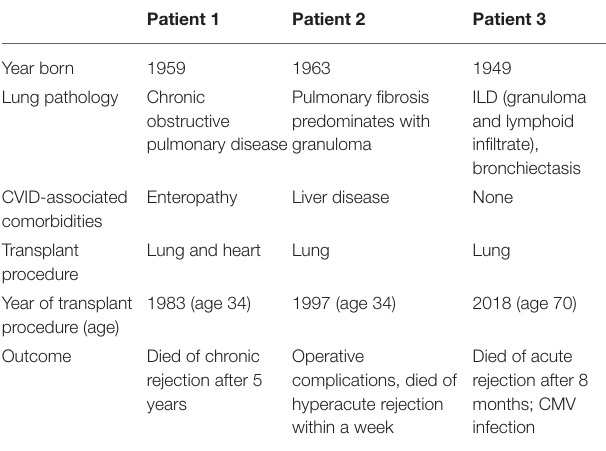
TABLE 4 | Treatment modalities used in the CVID patients with ILD in the study. Corticosteroids